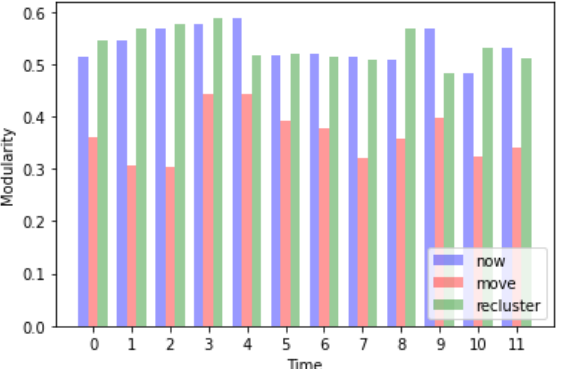
Figure 8. Variations of the graph modularity over time. The term ‘now’ represents the modularity at the start of a time slot t ; ‘move’ represents the modularity of the graph at the end of the time slot t . The results shown as ‘recluster’ are obtained when our adaptive module is used right after